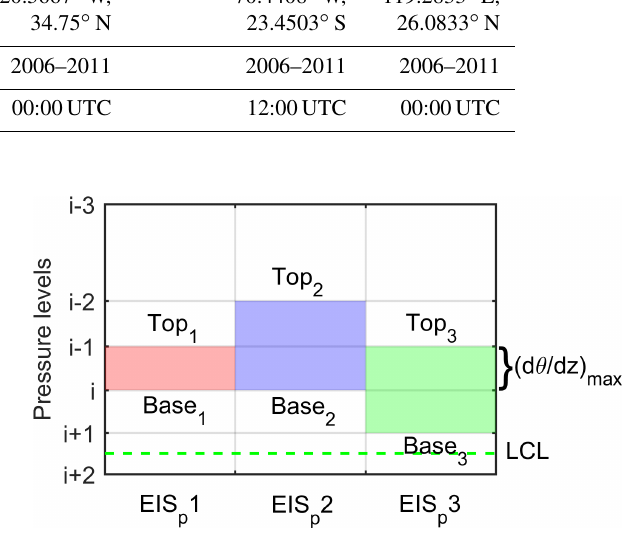
Figure 1. An illustration of finding the location of three possible layers encompassing the inversion between the LCL and 5kma.g.l. in ERA5 or coarse sounding profiles. The red block is one sin- gle layer of (d θ/ d z ) max that includes the inversion. The blue and green blocks are a combination of two adjacent layers if the inver- sion is distributed into the two layers but not just in the layer of (d θ/ d z ) max . EIS p 1–3 are computed accordingly, and the largest value among them is regarded as the true EIS p